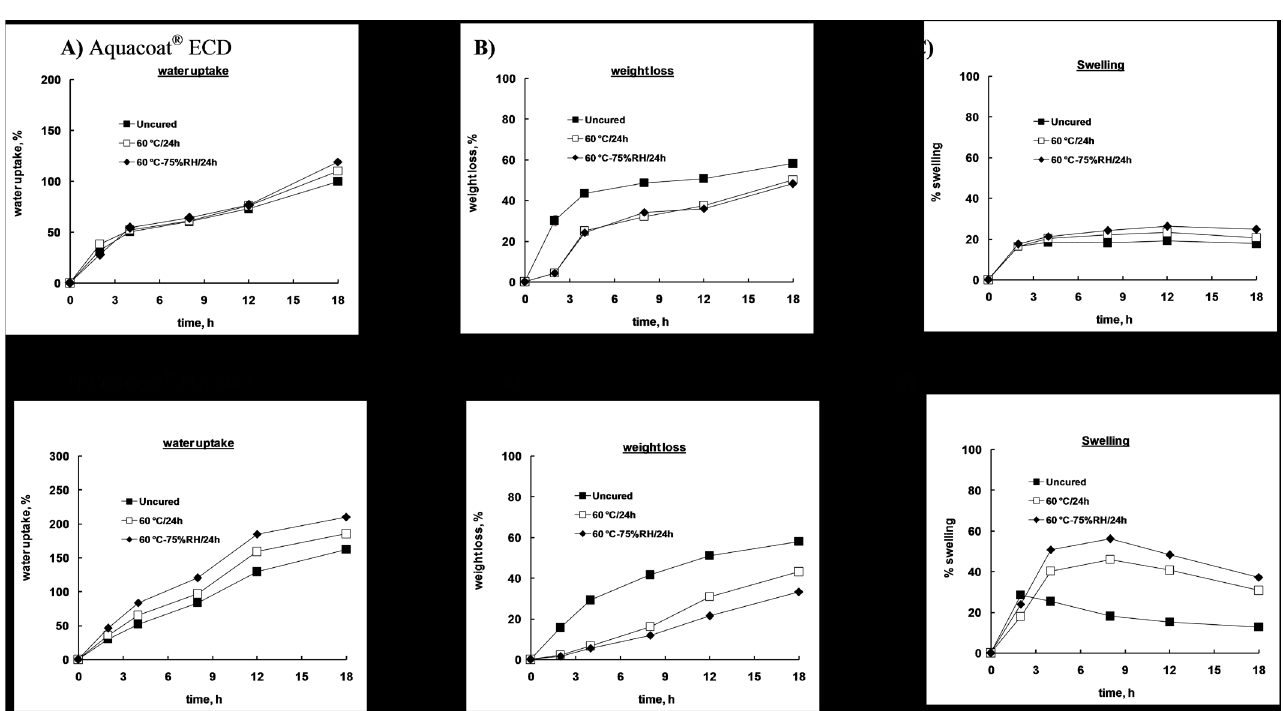
FIGURE 2 - Water uptake-weight loss and swelling of uncured and cured pellets as a function of time in 0.01 N HCl based on sugar cores loaded with 10% propranolol HCl and coated with: A-C) Aquacoat ® ECD and D-F) Eudragit ® NE 30D, coating level 20%.